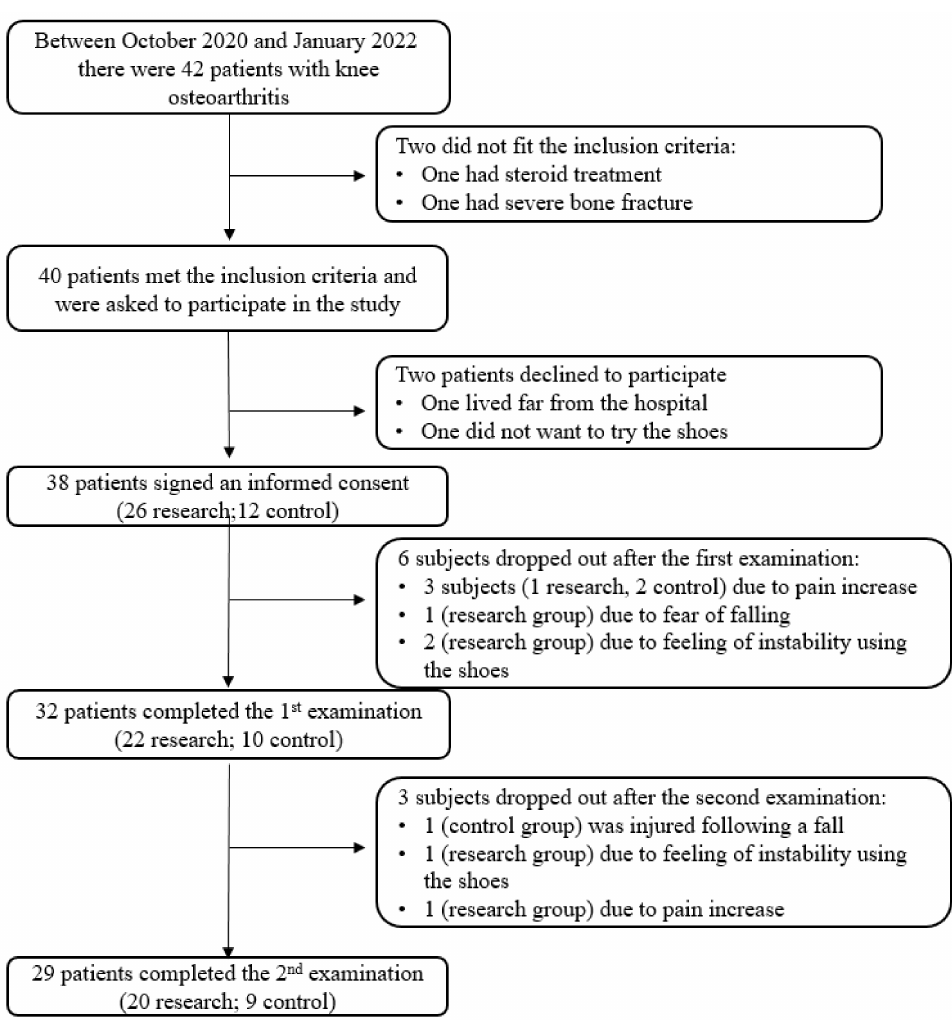
Figure 1. Recruitment process and drop outs during the